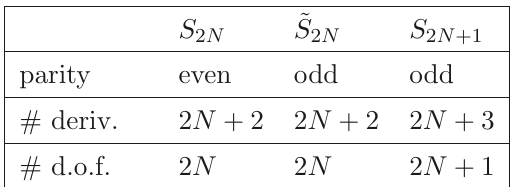
Table 2 . Parity preserving models, their number of derivatives and local degrees of freedom, N ≥ 0. S 1 is special and does not obey the rule in number of degrees of freedom as it enjoys one extra conformal gauge symmetry and consequently has zero